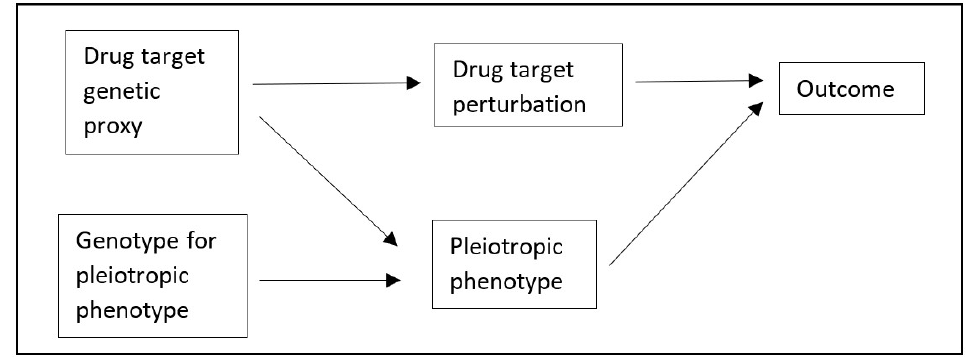
Figure 2. Directed Acyclic Graph (DAG) representing bias through pleiotropy in a cis -Mendelian randomisation analysis.